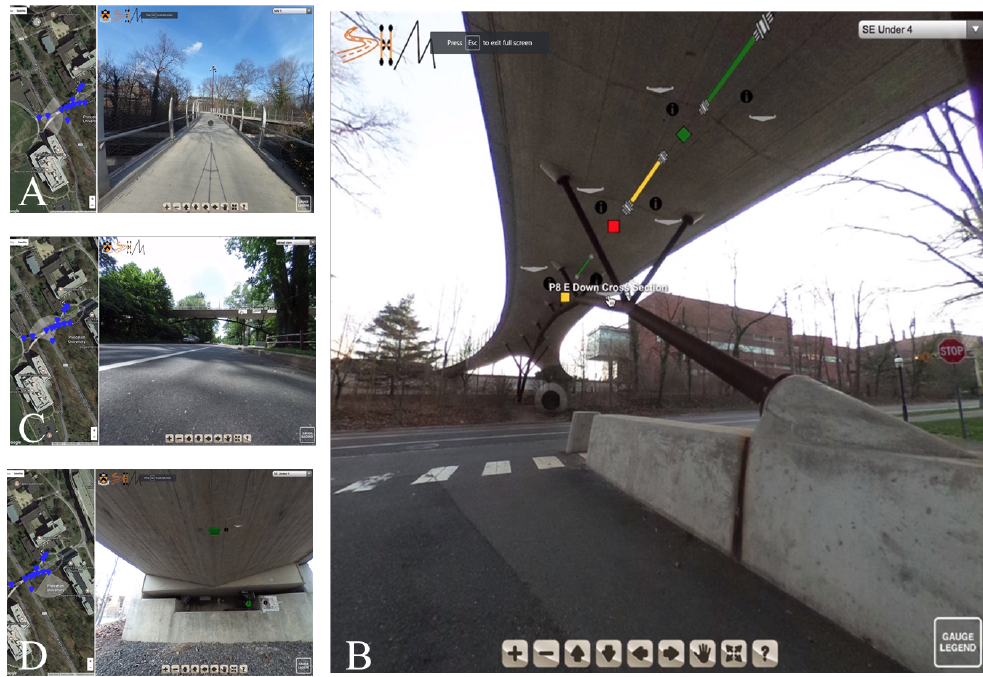
Figure 8. Stills of virtual (VT/IM) environment: ( A ) Scene 1 showing navigation elements; ( B ) Scene 2 showing sensors under the bridge; ( C ) Scene 3 showing global data on a side-view of the bridge; ( D ) Scene 4 showing displacement sensor and sensor sheet under South East